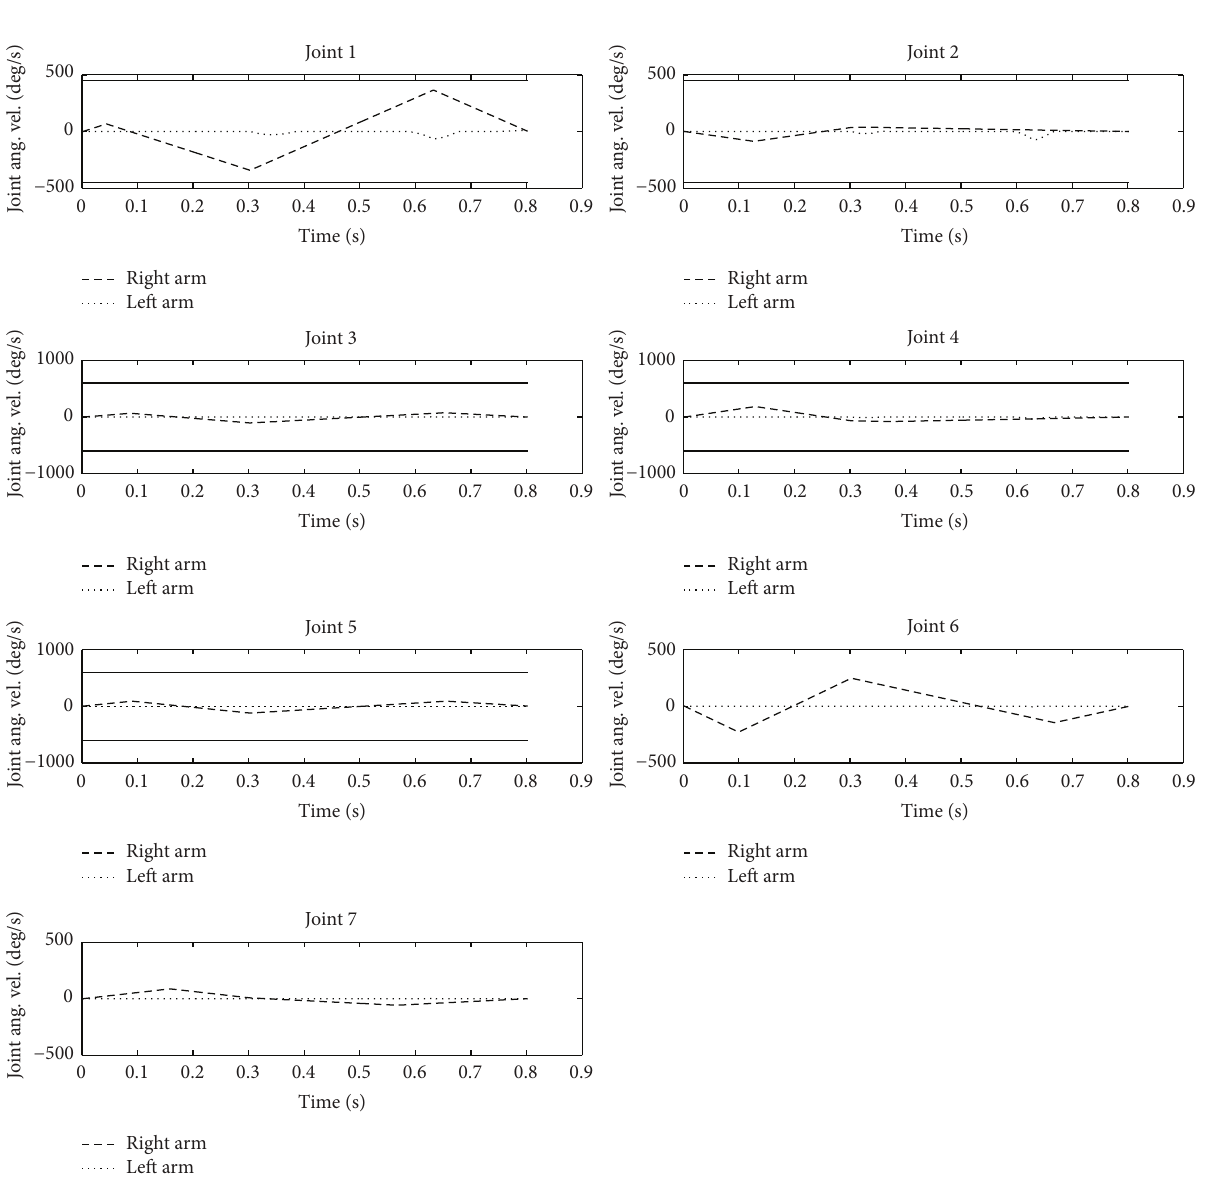
Figure 6: Angular velocity curve of the robot’s